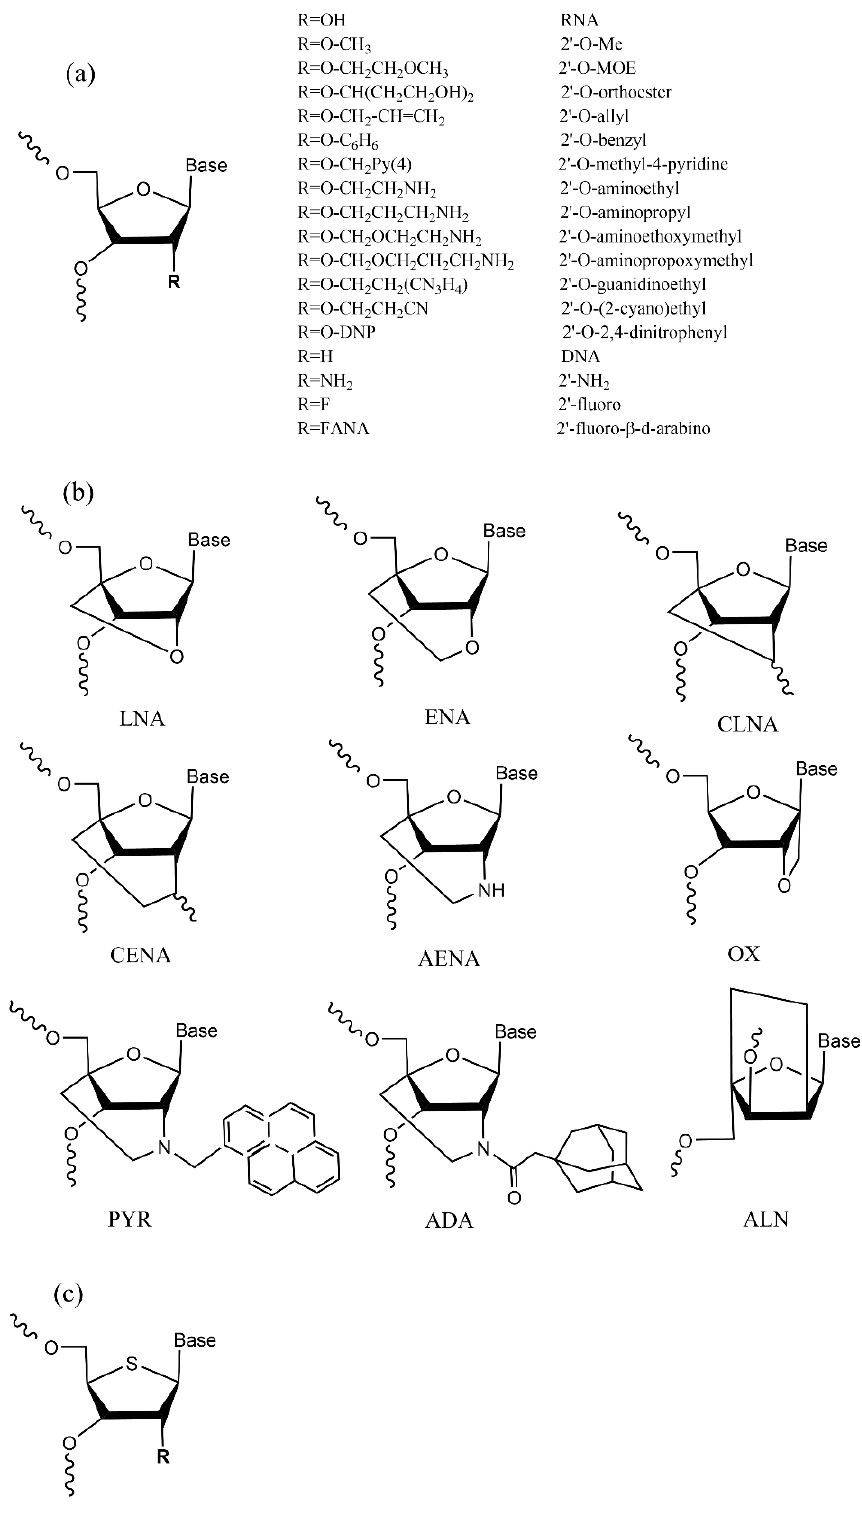
Figure 3. Chemical modification types of siRNA ribose. ( a ) 2 ′ position modifications of siRNA ribose; ( b ) Isomeric modifications of siRNA ribose. LNA, locked nucleic acid. ENA, ethyl-bridged nucleic acid. CLNA, 2 ′ , 4′ -carbocyclic-LNA-locked nucleic acid. CENA, 2 ′ , 4′ -carbocyclic-ENA- locked nucleic acid. AENA, 2′ -deoxy- 2′ -N, 4′ -C-ethylene-LNA. OX, oxetane-LNA. PYR, 2′ -N-pyren- 1-ylmethyl- 2′ -amino-LNA. ADA, 2′ -N-adamantylmethylcarbonyl- 2′ -amino-LNA. ALN, a-L-LNA; ( c ) 4′ -S modification of siRNA ribose.